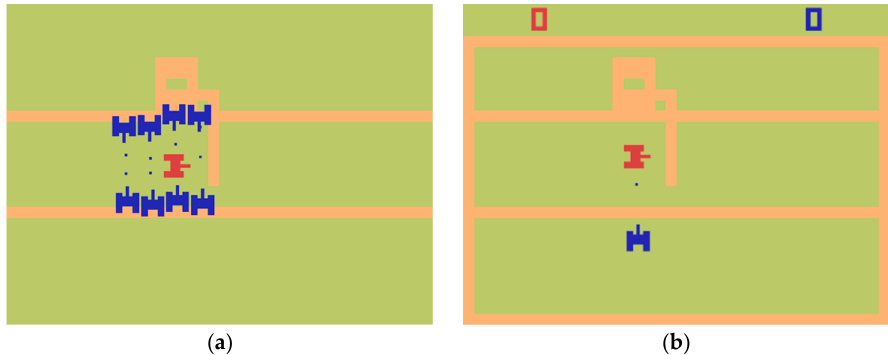
Figure 8. The ambush in The Godfather . ( a ) As originally envisaged with multiple attacking tanks in keeping with the film; ( b ) as reconceived with a single “Barzini tank” to adhere to Combat ’s platform restrictions.